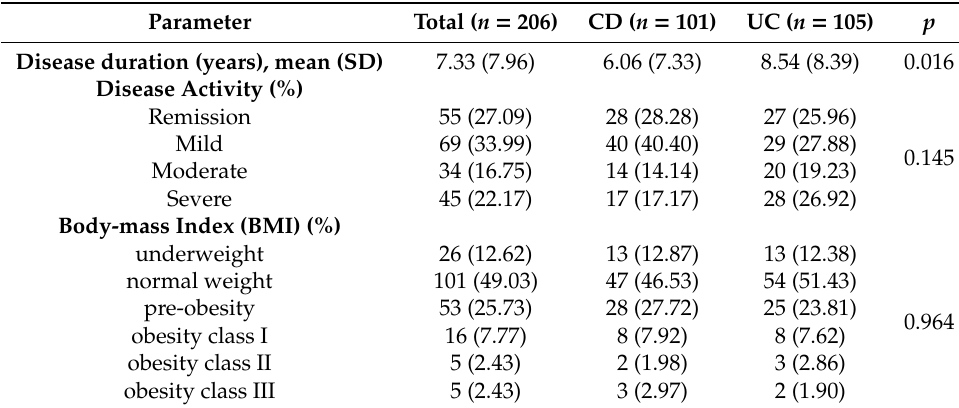
Table 3. Characteristics.